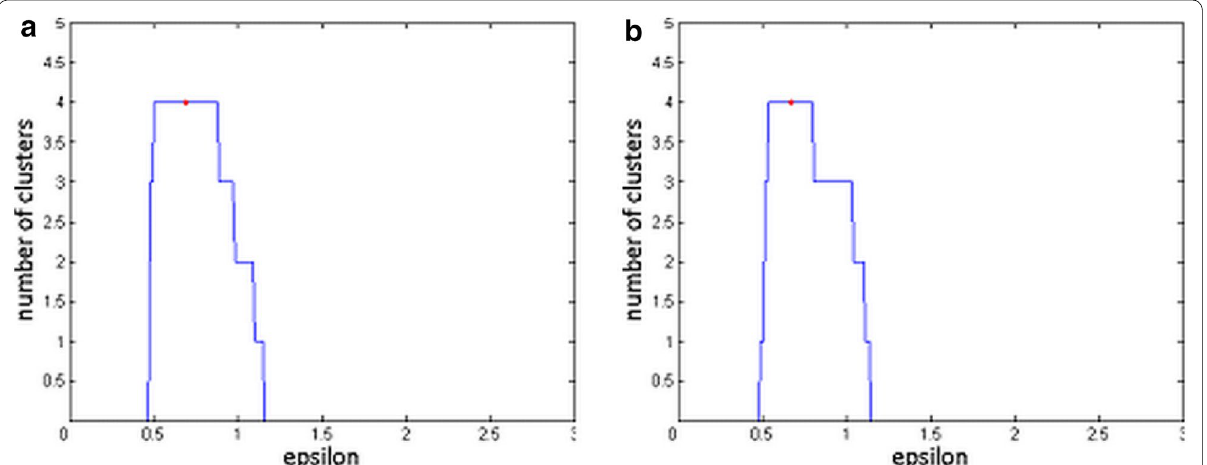
Fig. 3 Parameter choice in DBSCAN clustering: Epsilon plot for ( a ) SFC, and ( b ) DFC. The red dot refers to the final chosen epsilon